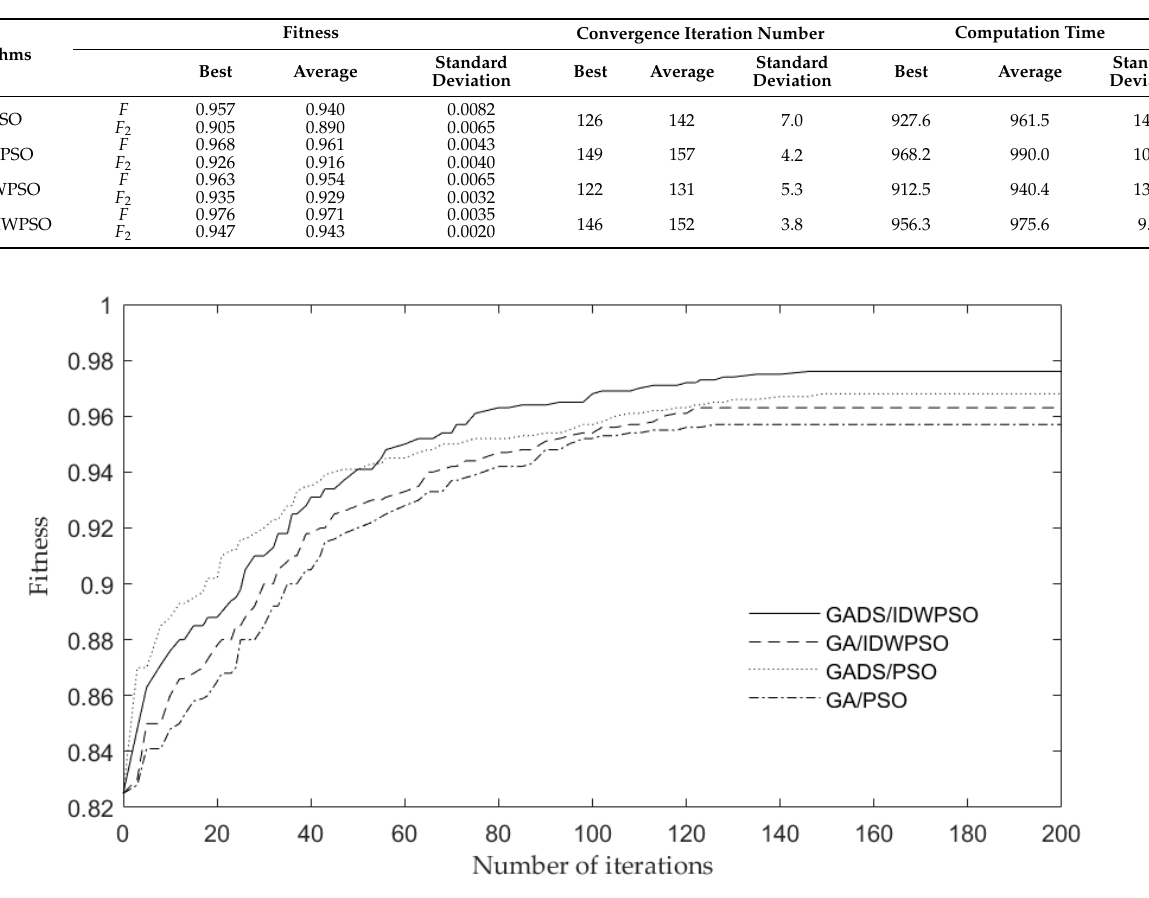
Figure 7. Algorithm iteration process.